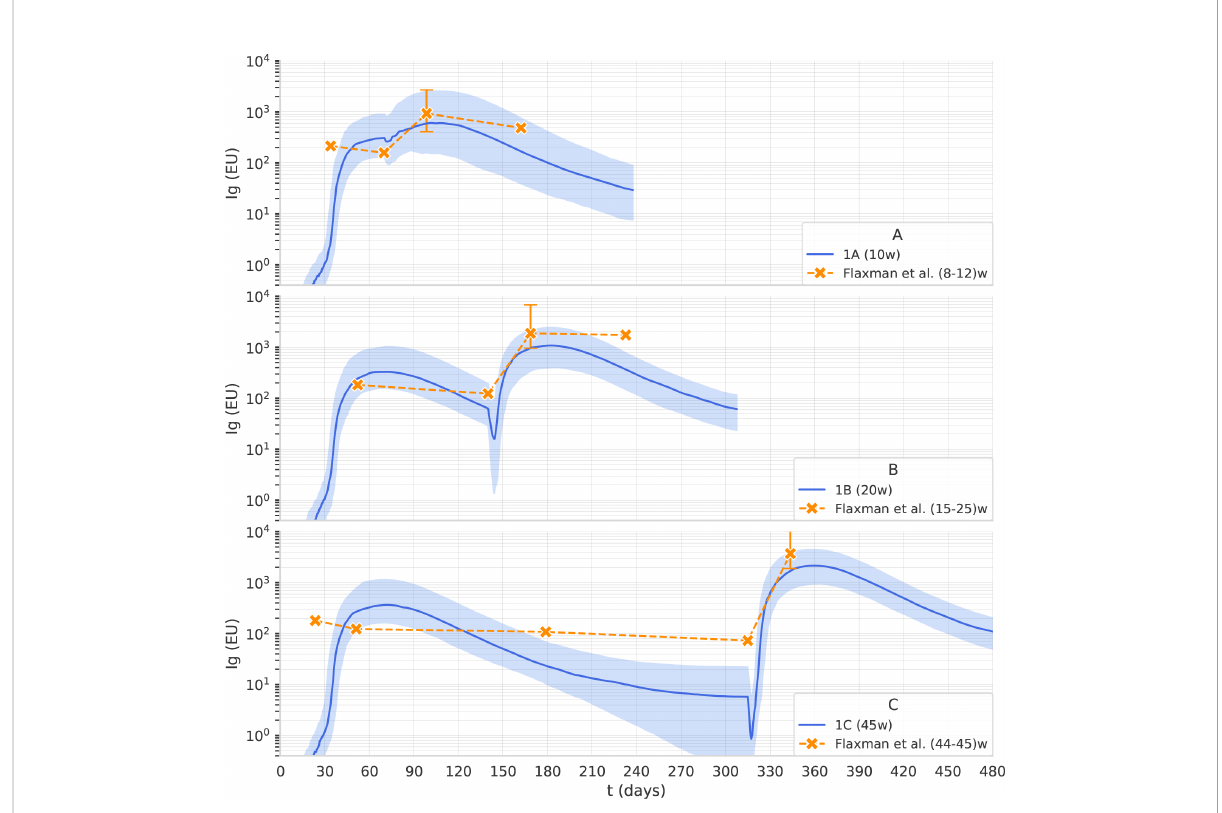
FIGURE 2 The computational model reproduces the effect of the dosing interval observed in clinical trials. Overlay of in-silico Ig levels in two-dose protocols 1A, 1B, and 1C (the line represents the median, the shading represents the IQR) with a dotplot representing median anti-Spike Elisa Units in clinical trial data from (11), corresponding to inter-dose periods of 8-12, 15-25 and 44-45 weeks for panel (A – C) ,